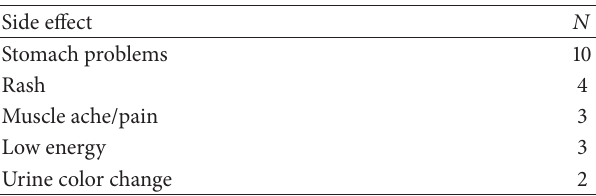
Table 3: Most common TB drug side effects reported in text messages